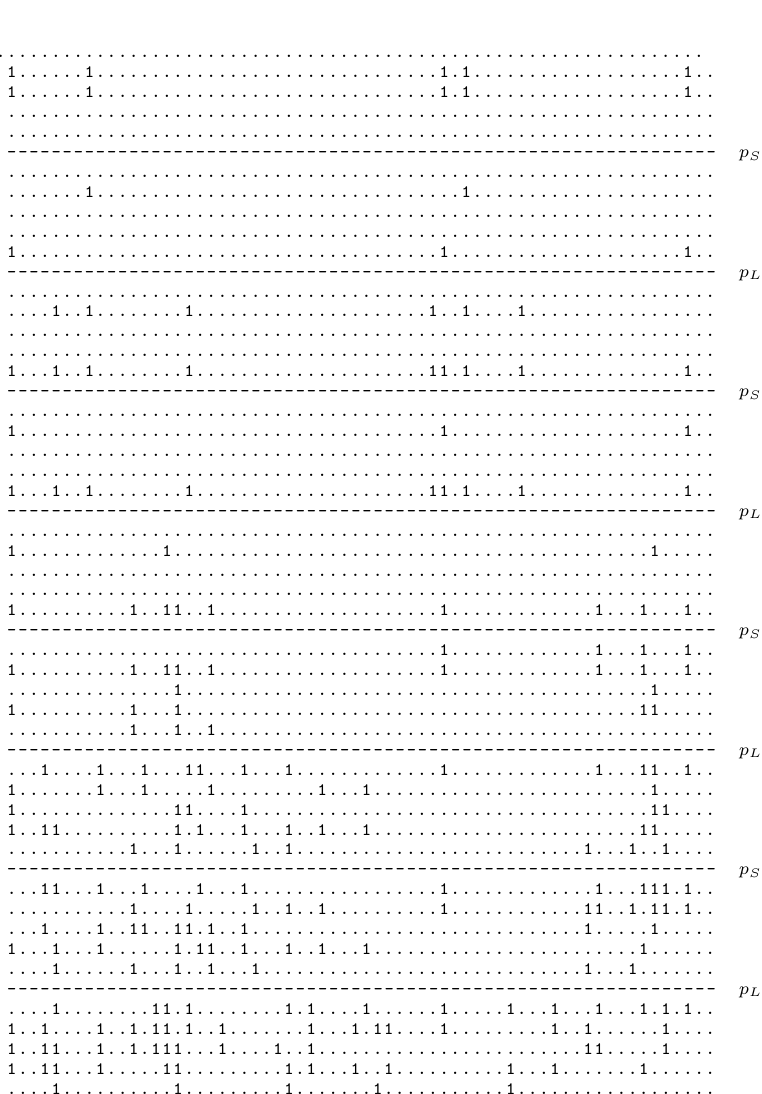
Figure 10: 5-round trail with 72 [5, 9, 10, 23, 25] active Sboxes and weight 225 [10, 33, 32, 74,